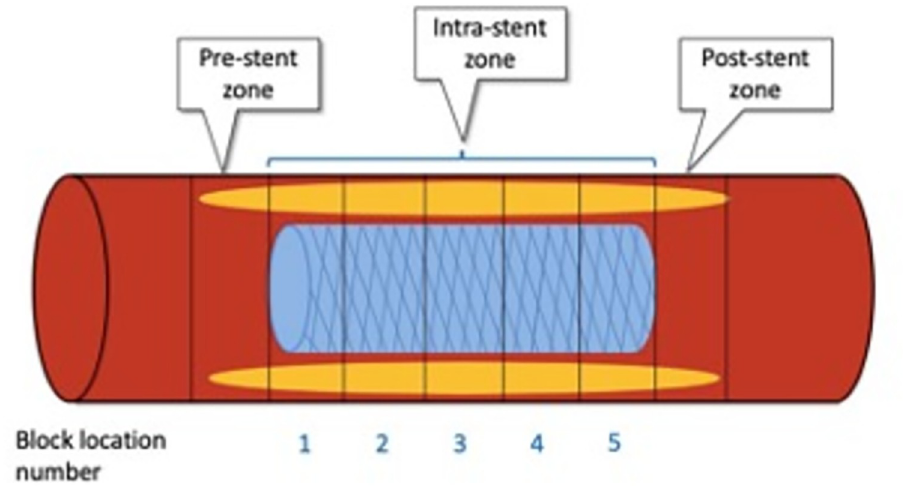
Fig 2. Pre-, intra- and post-stent zones composition with 5-mm blocks (vertical rectangles). Pre-stent zone is the most proximal zone, while post-stent zone is the most distal. Bioresorbable stents also have 2 platinum indicators located at the extremities of the stent in the intrastent blocks numbered 1 and 5. 2016 © ☯ Omar Arfa and Evguenia